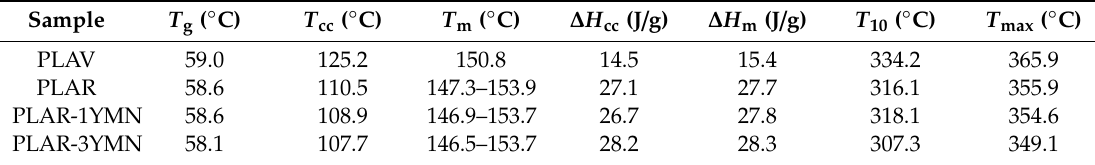
Table 2. DSC (second heating) results as well as TGA parameters of the di ff erent materials.